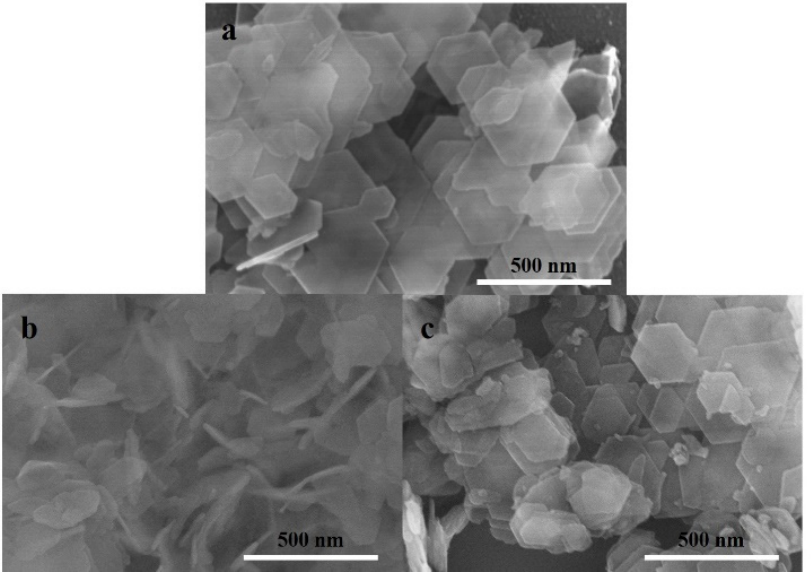
Figure 3. SEM images of ( a ) HMCM-49, ( b ) C-Mo-HMCM-49, and ( c ) N-Mo-HMCM-49.